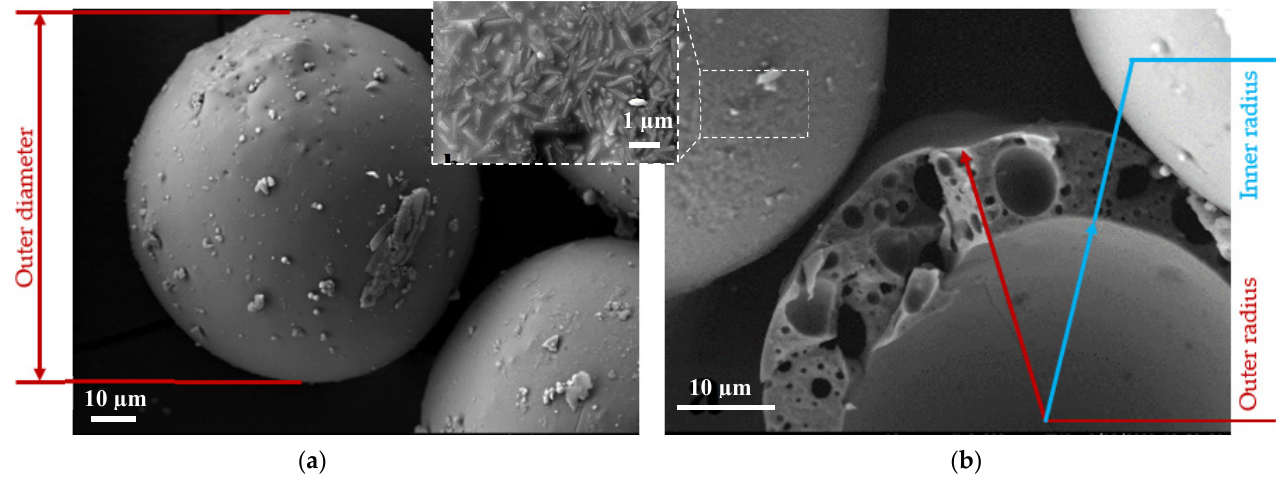
Figure 1. Microstructure and phase analysis of the aluminosilicate cenospheres: ( a ) Outer view (including crystalline structures at 1 μm scale); ( b ) Inside view (inner radius of internal pore and closed pores inside the wall of the cenosphere).